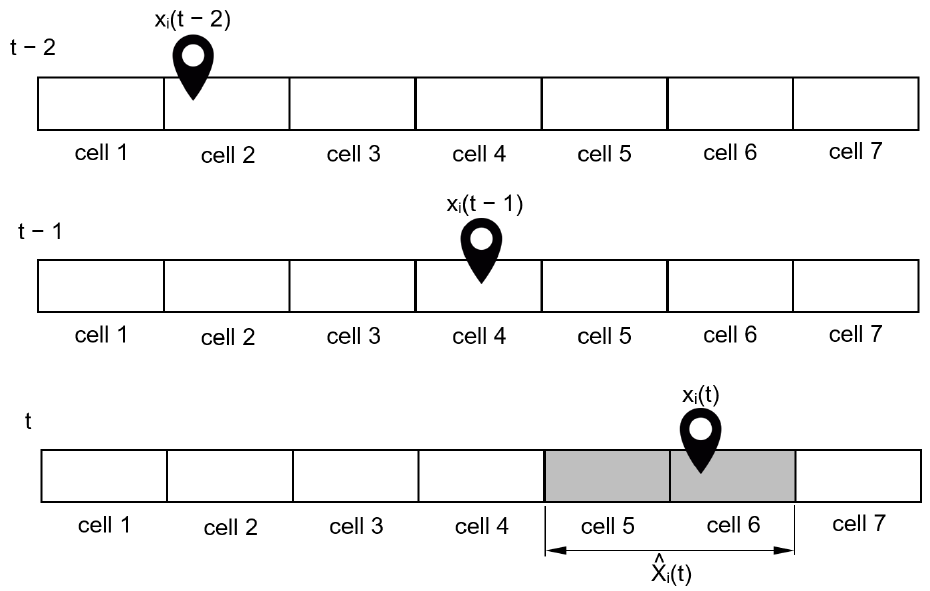
Figure 1. Positions of vehicle described by cell interval model for single traffic